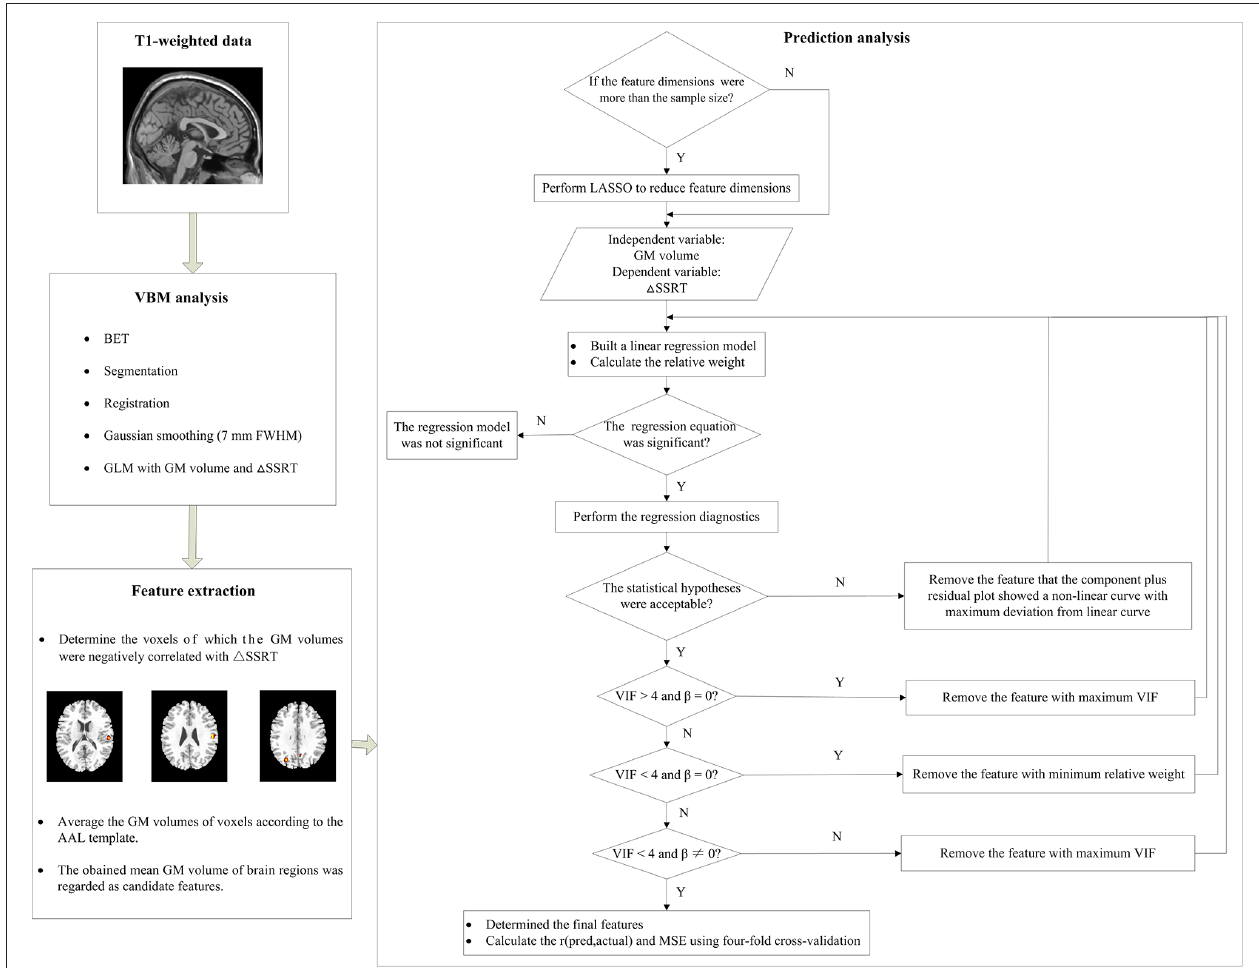
FIGURE 3 | A schematic diagram of the prediction analysis pipeline. First, the T1-weighted data underwent the voxel-based morphometry (VBM) analysis to find the relationship between gray matter (GM) volume and (cid:49) SSRT. Second, we extracted features from the results of the VBM analysis, and determined the voxels which GM volumes were negative correlated with the (cid:49) SSRT at an uncorrected threshold. The GM volumes of voxels were then averaged according to the automated anatomical labeling (AAL) template. The obtained mean GM volumes of brain regions were regarded as candidate features. Third, we used these candidate features to predict the (cid:49) SSRT with a linear regression model. If the feature dimensions were higher than the sample size, we performed least absolute shrinkage and selection operator (LASSO) to reduce the feature dimensions before building the linear regression model; otherwise, we directly built the linear regression model. We then evaluated the applicability of this model according to the following conditions: (1) the regression model was significant; (2) the linear regression model met the statistical hypotheses (normality, independence of errors, linearity, and homoscedasticity); (3) the regression coefficients ( β ) of all features were significant; (4)